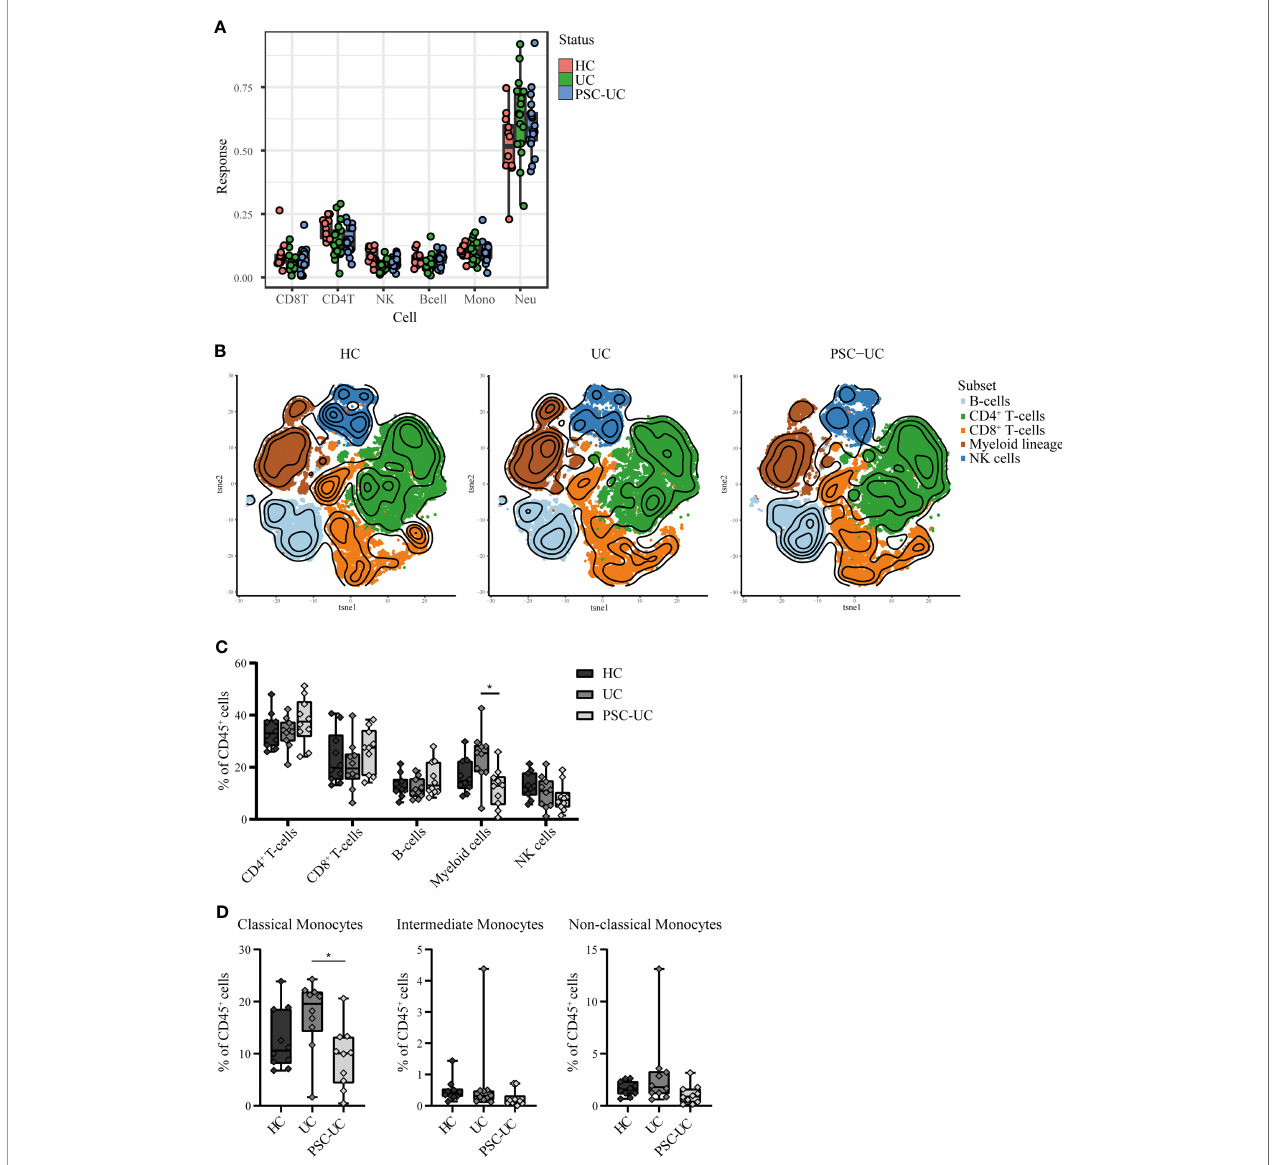
FIGURE 4 | High-dimensional mass cytometry (cyTOF) analysis reveals that peripheral blood cell distribution is comparable between patients with PSC-UC, UC and HC. (A) Estimated cell proportions as derived from Houseman algorithm cell mixture deconvolution from DNA methylation data of PSC-UC (blue), UC (green) and HC (red). (B) The lineages CD4 + T-cells, CD8 + T-cells, B-cells, myeloid cells and NK-cells were clustered for PSC-UC, UC and HC and color-coded visualized using vISNE. (C) Differences in frequencies of CD4 + T-cells, CD8 + T-cells, B-cells, Myeloid lineage and NK-cells as percentage of total CD45 + cells in HC (n = 9), UC (n = 10) and PSC-UC (n = 10). (D) Differences in frequencies of classical monocytes, intermediate monocytes and non-classical monocytes percentage of total CD45 + cells in HC (n = 9), UC (n = 10) and PSC-UC (n = 10). Statistical testing was performed using Kruskal Wallis with Dunn ’ s correction for multiple testing. A p-value < 0.05 was considered statistically signi fi cant (*p <